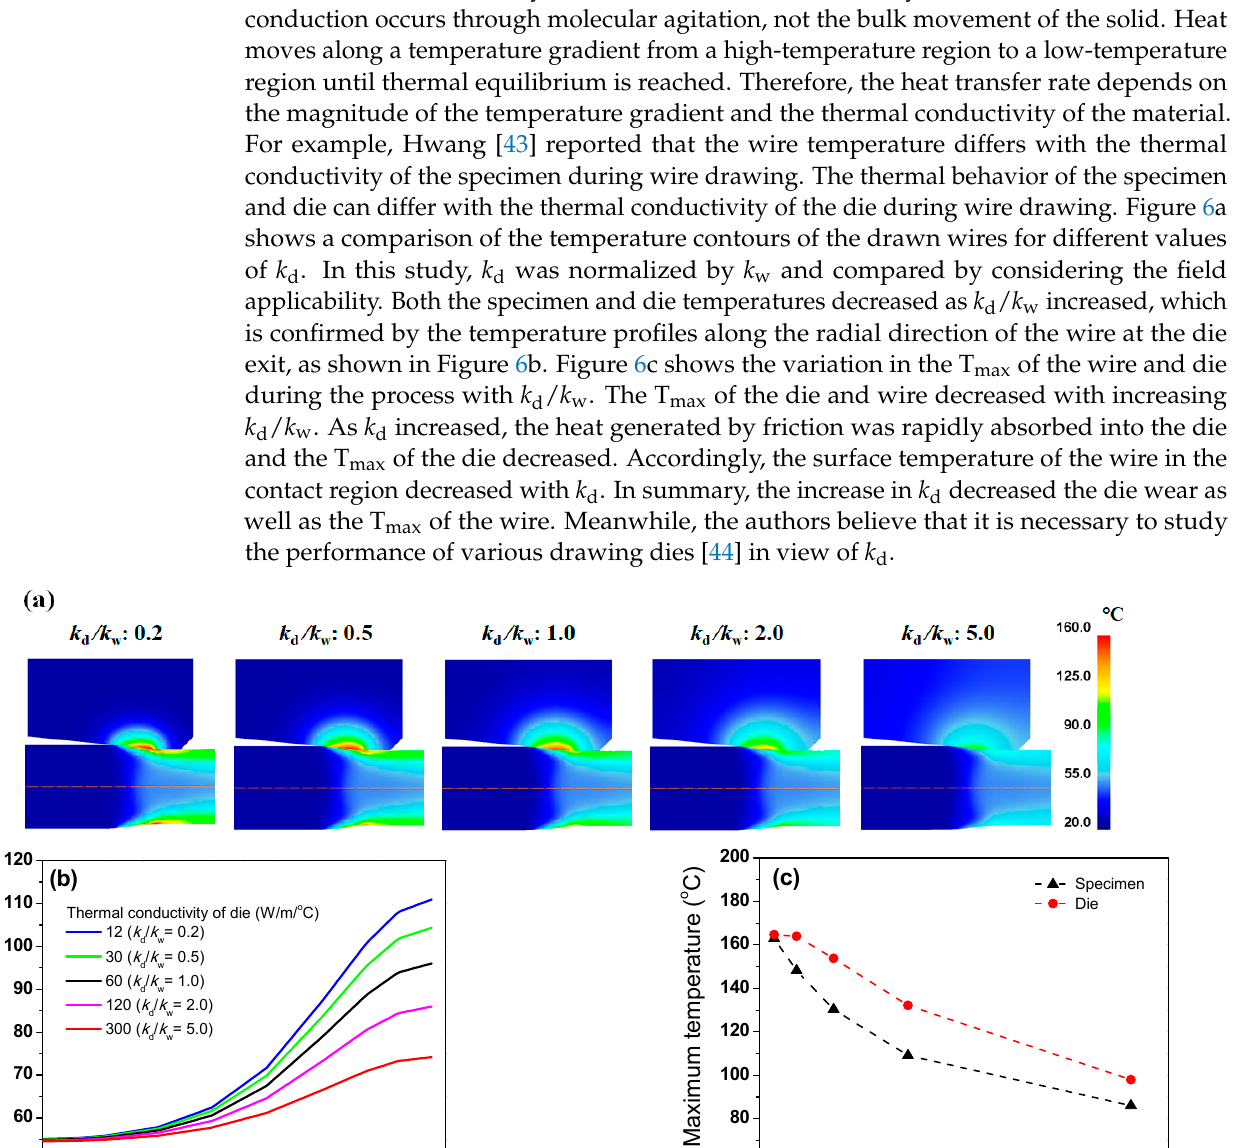
Figure 5. Comparison of temperature ( a ) contours and ( b ) profiles along the radial direction of wire at die exit; ( c ) T max of wire and die vs. contact heat transfer coefficient.